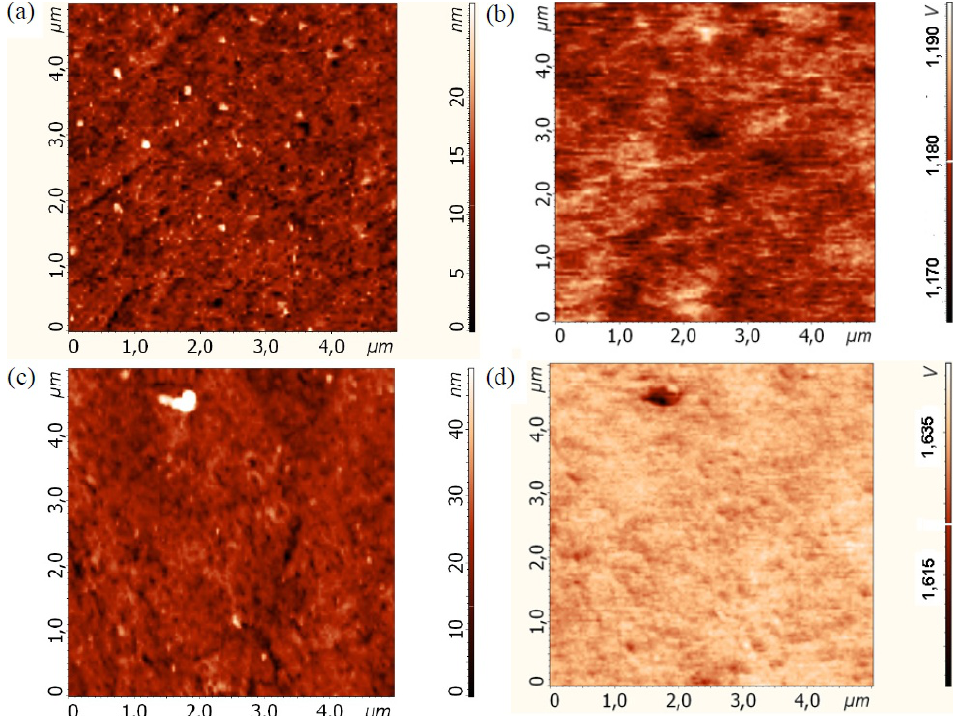
Fig. 1. AFM topography images of the surface (a, c) and the corresponding maps of the distribution of the SKPM signal over this surface (b, d) for samples of Al in the initial CG state (a, b) and in UFG state obtained by HPT processing (c,